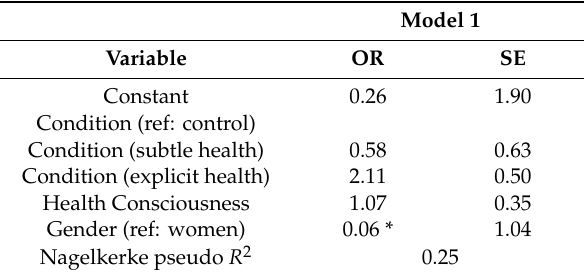
Table 3. Results of the logistic regression models for the logit to choose a healthy food product with the control condition as reference category ( n =